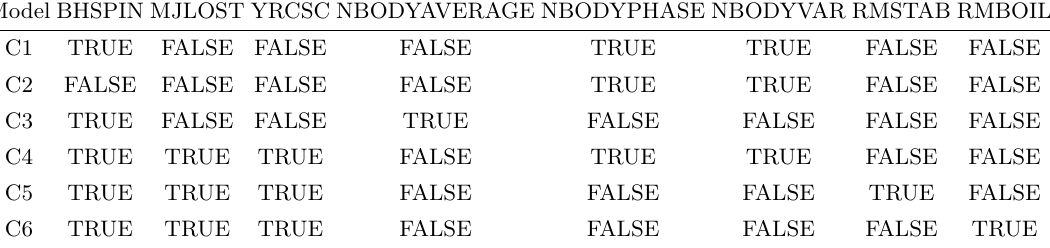
Table 2 . Generator settings used for charybdis 2 signal sample